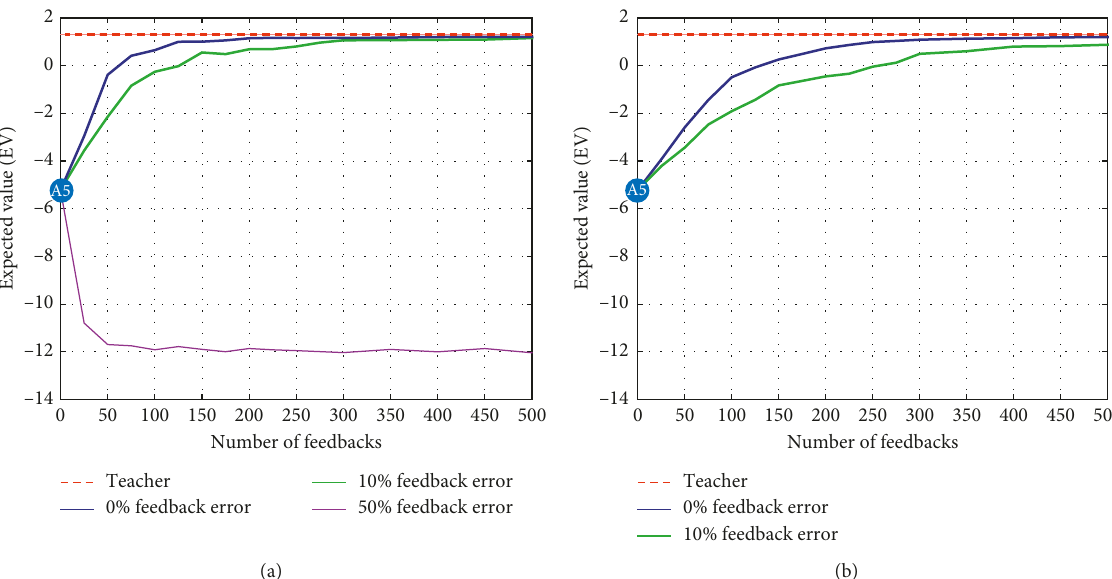
Figure 9: (a) The performance of IRLDC framework under different feedback error values used in the interactive phase when 100 state- action pairs of 60% optimal demonstrations are given (see Table 2). (b) The performance of our previous work (LfDHF) [15] with similar setting to